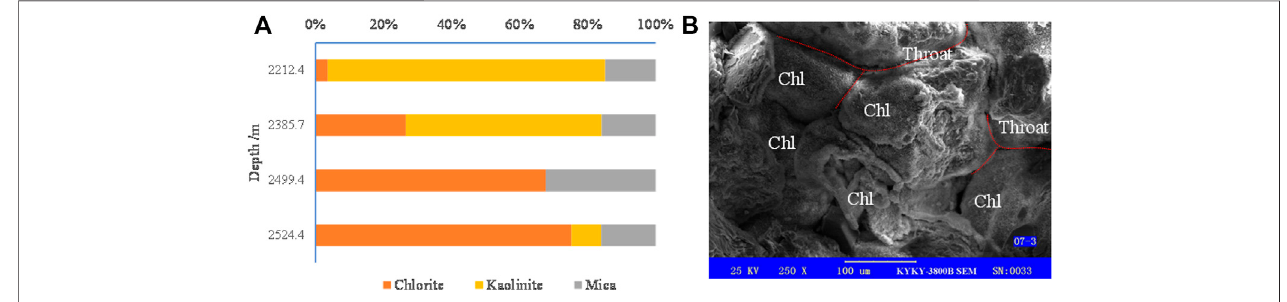
FIGURE 8 | (A) Histogram of mineral content as depth increases. (B) SEM image showing the optical characteristics of chlorite which protect the pores.